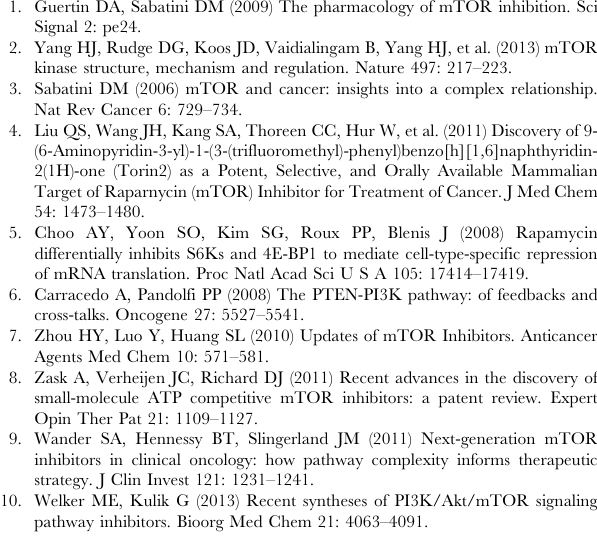
Figure S2 Correlations between the sum of N plus O atom counts and mTOR inhibition index. (TIF) Figure S3 Structures of the predictions for the 37 tested compounds using the top three RP, and Bayesian and ACFs-NB classifiers. (TIF) Table S1 The classification performance of RP models for training set based on the matthews correlation coefficient ( C ) using different tree depth. Table S2 The classification performance of thirteen RP models for test set based on the matthews correlation coefficient ( C ) using different tree depth. Table S3 The classification performance of ACFs clas- sifiers for test set. Table S4 The classification performance of RP and Bayesian classifiers based on three cutoff